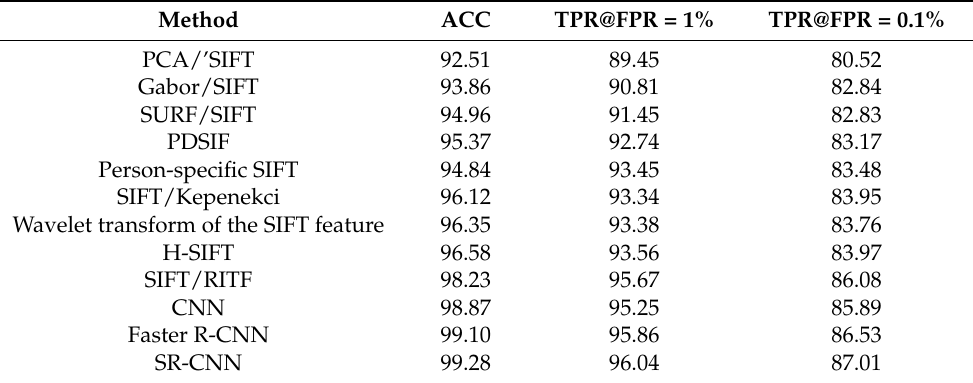
Table 3. Recognition performance of different improved models using the self-collection dataset.